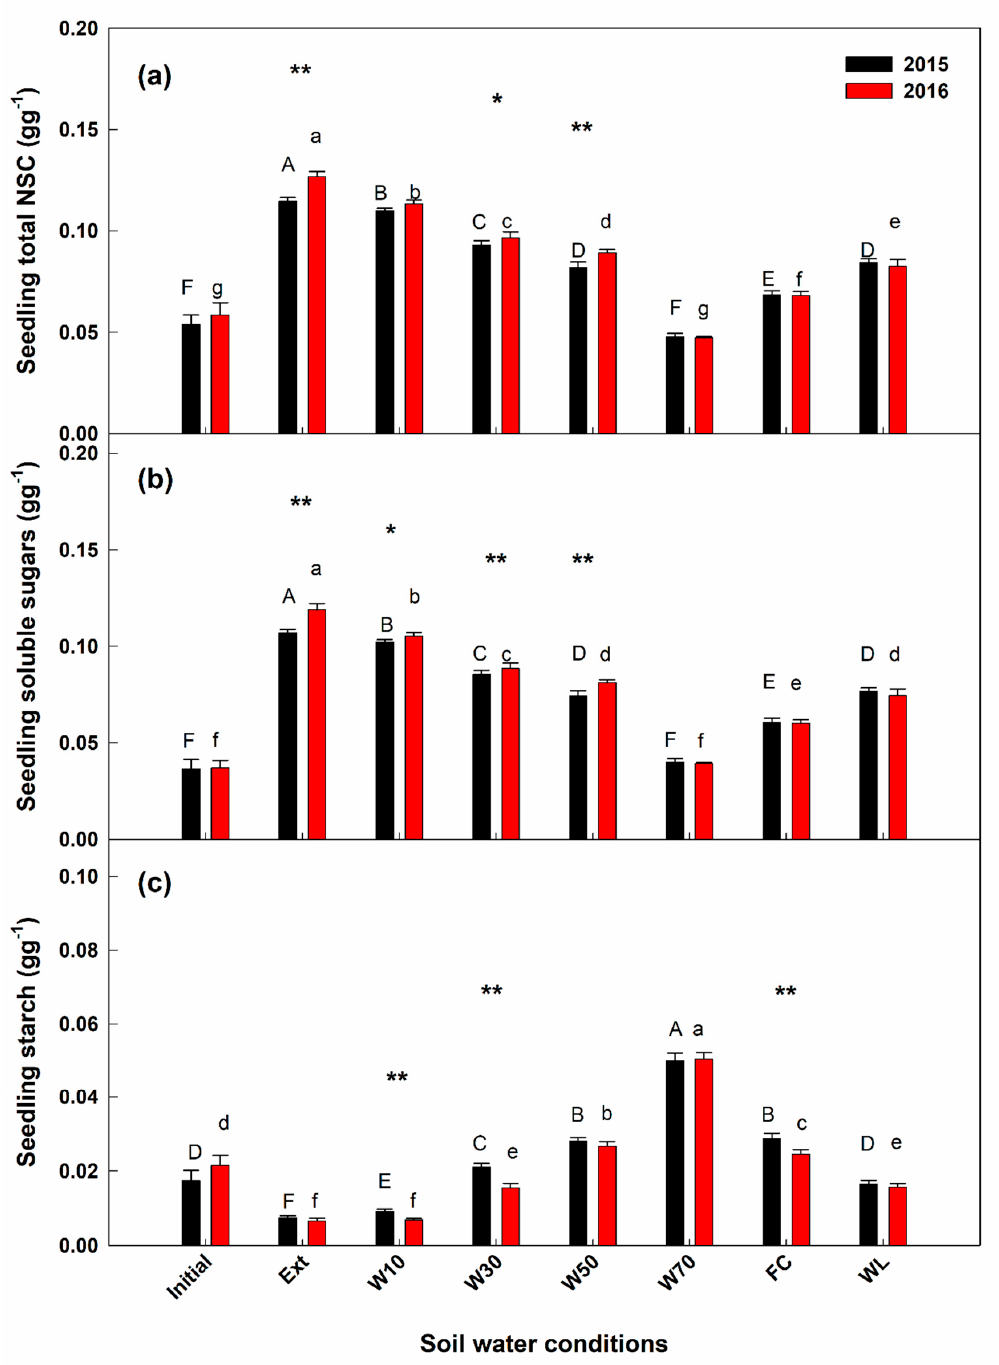
Figure 2. Changes in total non-structural carbohydrates (TNSC), soluble sugars (SS) and starch at the end of the 10-day water status treatments in 2015 (black bars) and 2016 (red bars), expressed as concentrations (g g − 1 ) and ( a ) stands for seedling TNSC, ( b ) for seedling SS and ( c ) for seedling starch. The treatments are Ext: extreme drought, W10: 10% of field capacity (FC), W30: 30% of FC, W50: 50% of FC, W70: 70% of FC, and WL: permanently waterlogged. Asterisks indicate a significantly different values (*, p < 0.05; **, p < 0.01; ***, p < 0.001) between 2015 and 2016. Different letters indicate significant differences between treatments in each year. The upper-case letter refers to 2015 and the lower-case letter refers to 2016.